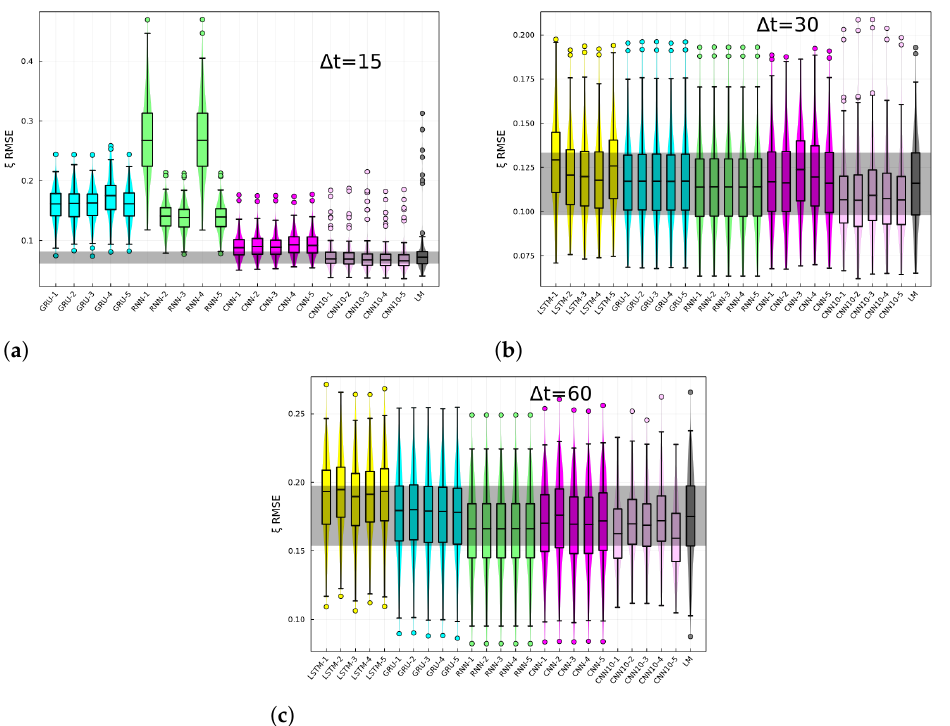
Figure 3. BG-risk standardized variable, ξ , RMSE for ( a ) 15, ( b ) 30, and ( c ) 60 min prediction horizon. Each panels shows the RMSE for different architectures specified in the x -axis and for the last-measurement prediction (LM). Each box corresponds to the model tested on N − 10